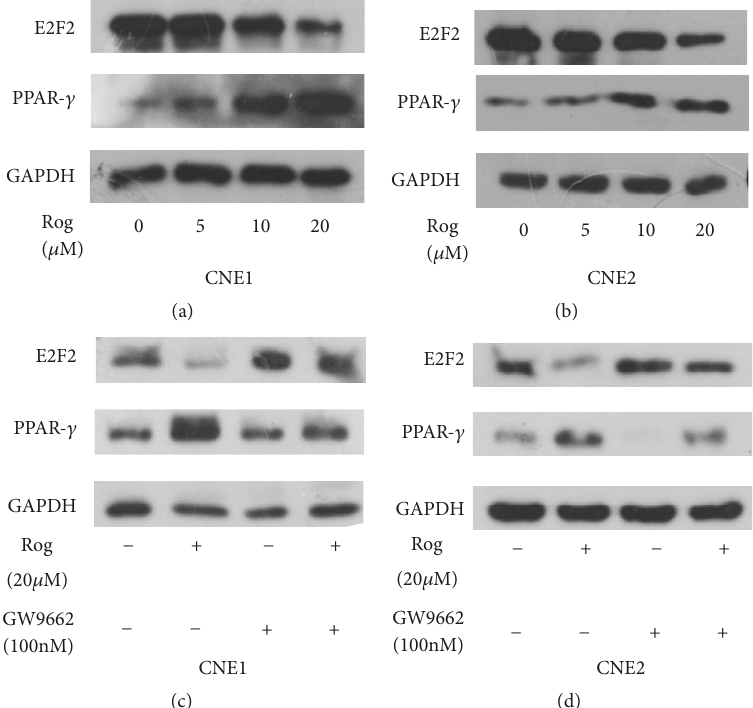
Figure 4: E2F2 and PPAR- 𝛾 expression in CNE1 and CNE2 nasopharyngeal carcinoma cells after treatment with PPAR- 𝛾 ligand . (a, b) Western blotting was performed to detect the expression of E2F2, PPAR- 𝛾 , and GAPDH in CNE1 and CNE2 cells after treatment with dose-dependent PPAR- 𝛾 agonist Rog. (c, d) Western blotting was performed to detect the expression of E2F2, PPAR- 𝛾 , and GAPDH in CNE1 and CNE2 cells after treatment with PPAR- 𝛾 agonist (rosiglitazone, Rog) and PPAR- 𝛾 antagonist